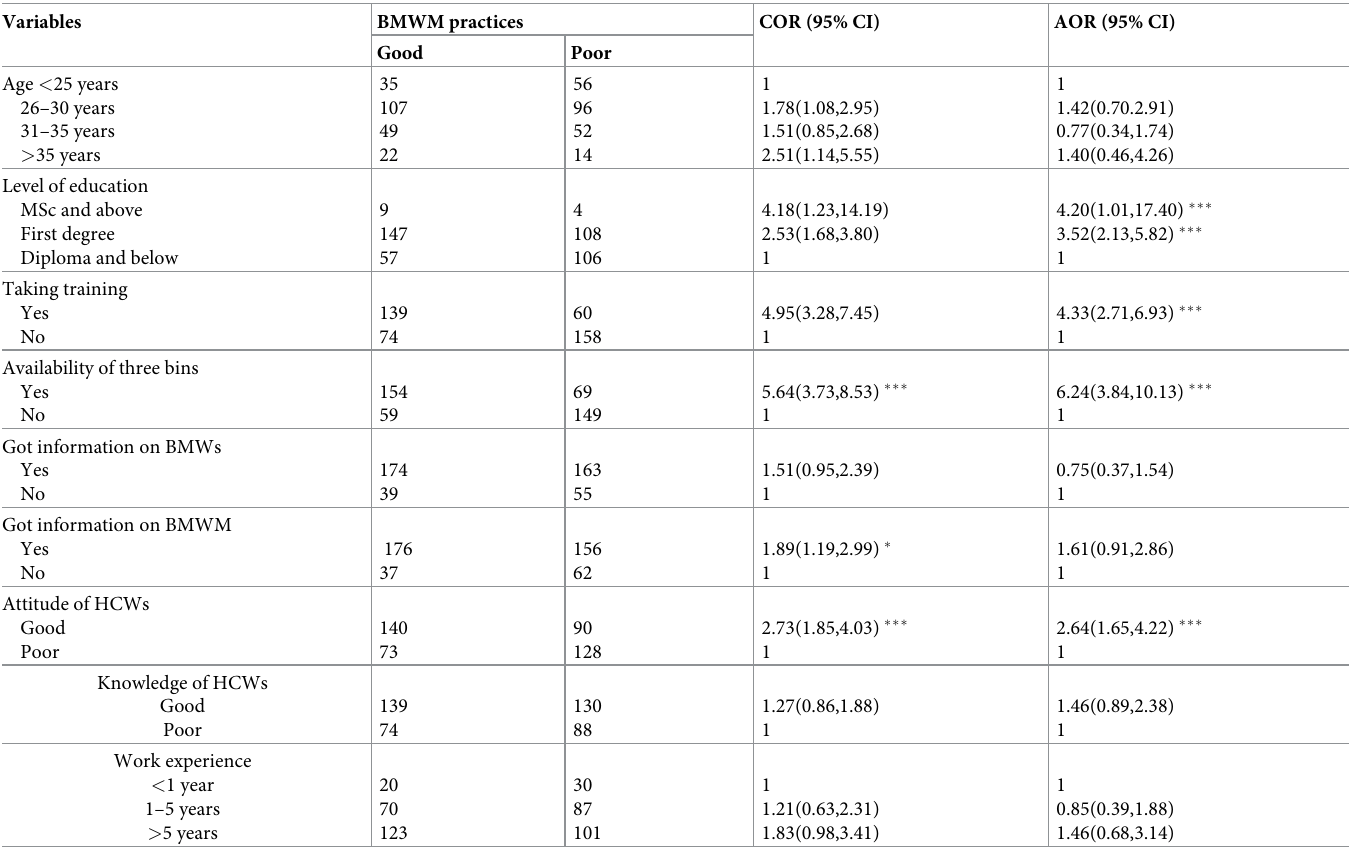
Table 6. Multivariable binary logistic regression analysis for factors associated with biomedical waste management practices among health care workers in metro- politan cities private hospitals of Amhara region, Ethiopia